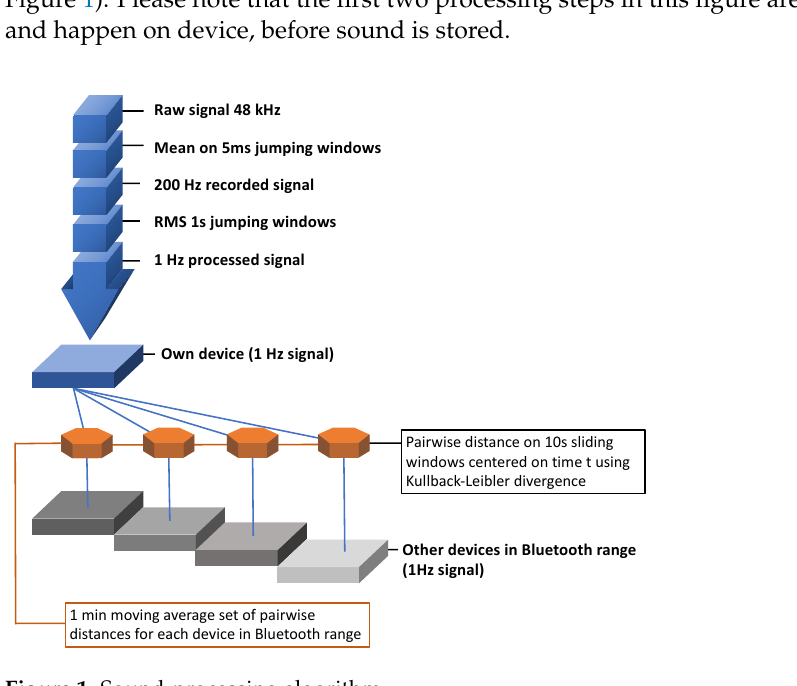
Figure 1. Sound-processing